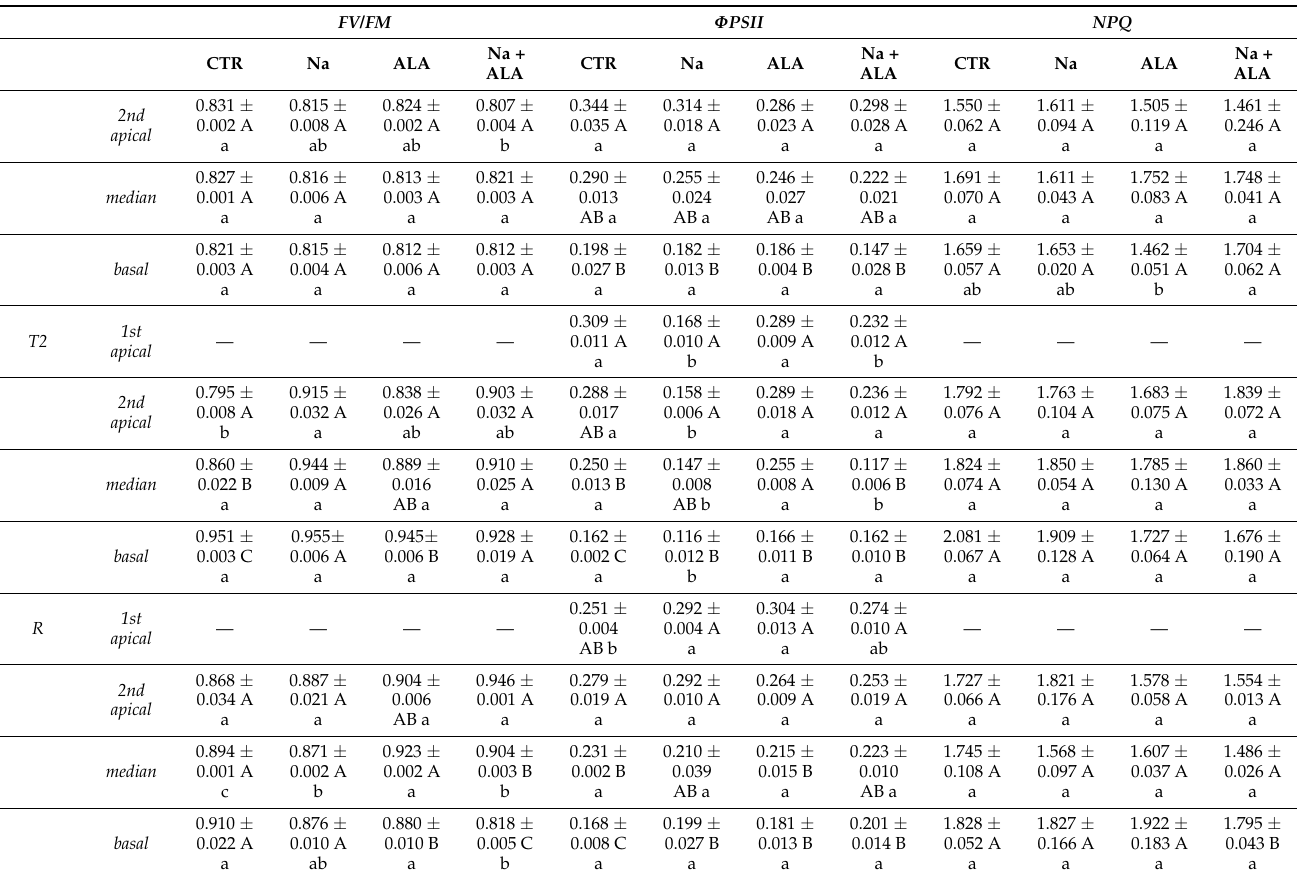
Table 3. Concentration of indol-3-Acetic Acid (IAA) and abscisic acid (ABA) (pmol/g FW) measured at different time points (T1, T2, and R) in apical, median, and basal leaves along the profile of Arundo donax controls (CTR), salt-stressed (Na), ALA-treated (ALA), and both salt-stressed and ALA-treated (Na + ALA) plants. Mean values ± SE are shown. At any time-point, uppercase letters indicate statistically significant differences among (apical, median, and basal) leaves of plants undergoing the same treatment, and lowercase letters indicate statistically significant differences between (apical, median, and basal) leaves of plants undergoing different treatments ( p < 0.05; n = 3). CTR Na ALA Na + ALA 295.4 ± 2030.3 ± 41.7